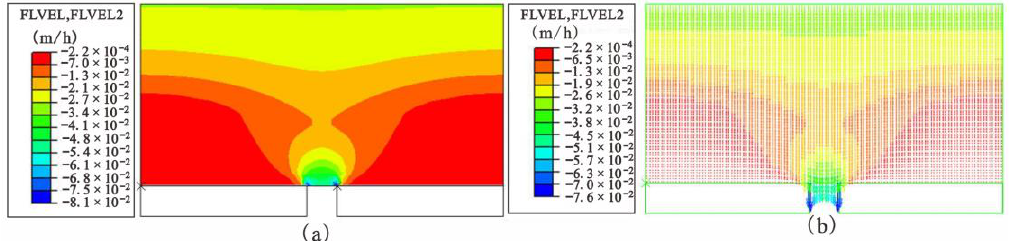
Figure 13. Pore water pressure and saturation contour plots. ( a ) is the initial pore water pressure and saturation contour plots; ( b – d ) are the pore water pressure and saturation contour plots in 6 h, 12 h and 24 h after the start of rainfall respectively.